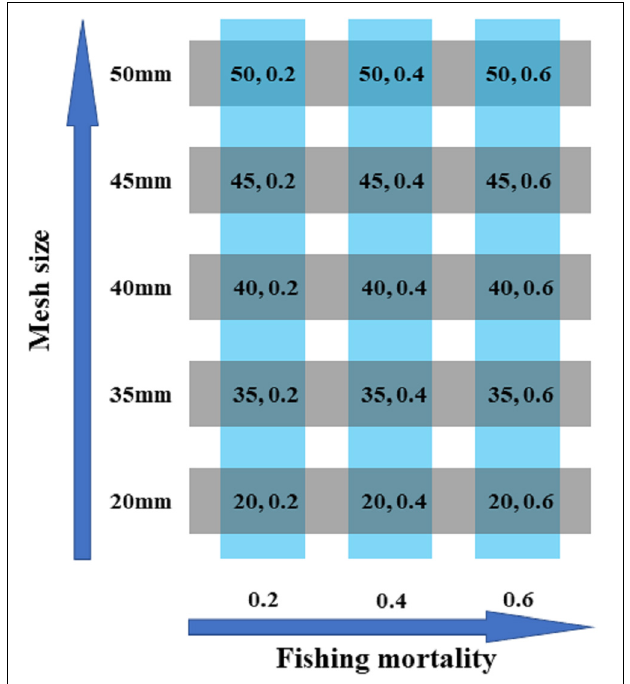
FIGURE 2 | A total of 15 harvest scenarios set with mesh size and fishing mortality.